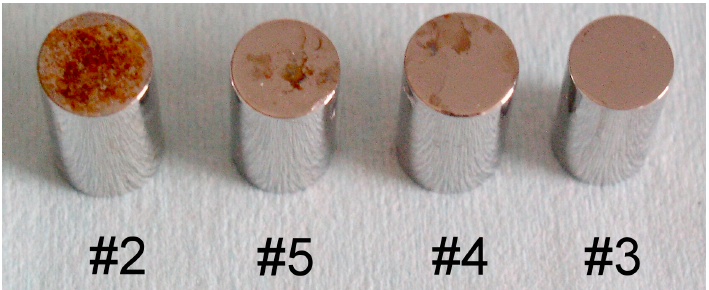
Figure 5. Uniform corrosion salt fog test, according to ASTM B 117-97. Samples #2-1.4427 So, #3-1.4435 / 316L, #4-316LUgim and #5-316L Val.